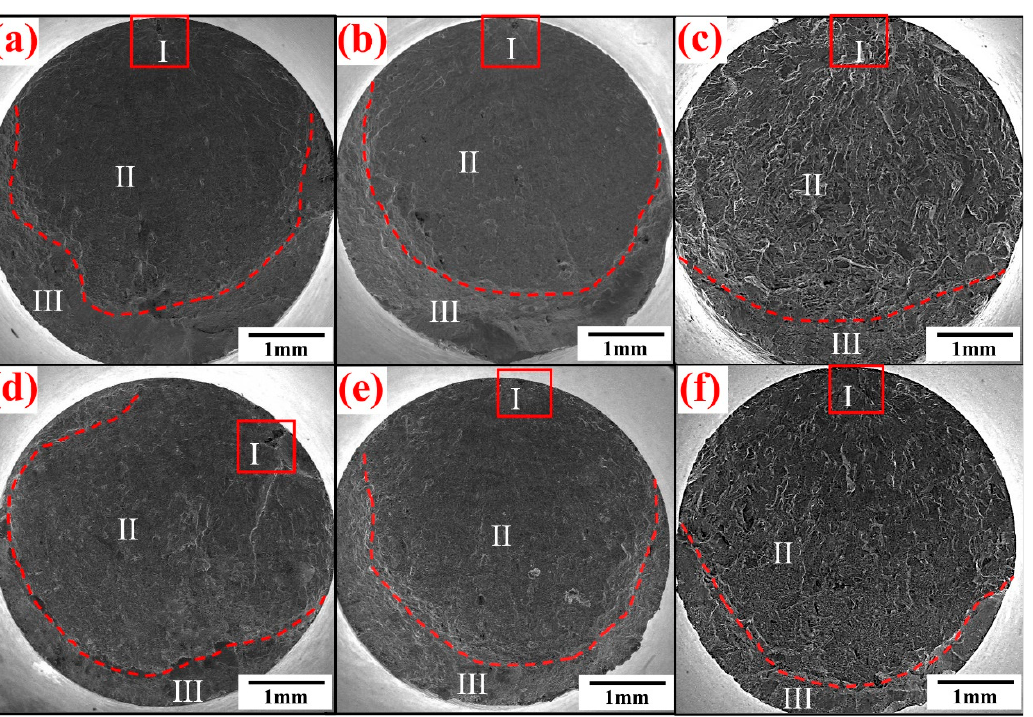
Figure 8. Macroscopic fatigue fracture surface of different specimens: ( a ) 850FC (2,733,000 cycles), ( b ) 950FC (575,400 cycles), ( c ) 1050FC (78,700 cycles), ( d ) 850WAC (1,521,300 cycles), ( e ) 950WAC (671,100 cycles), ( f ) 1050WAC (141,700